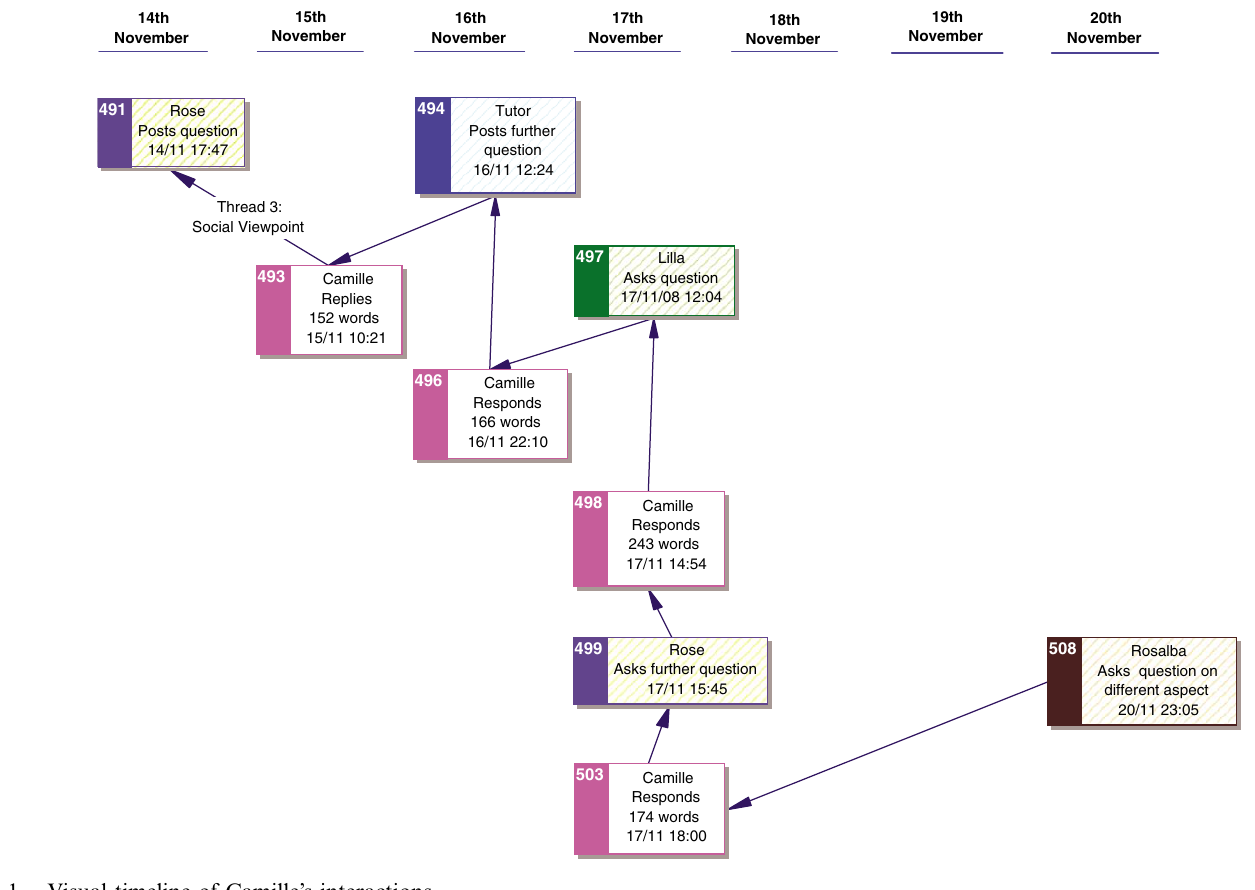
Figure 1. Visual timeline of Camille’s